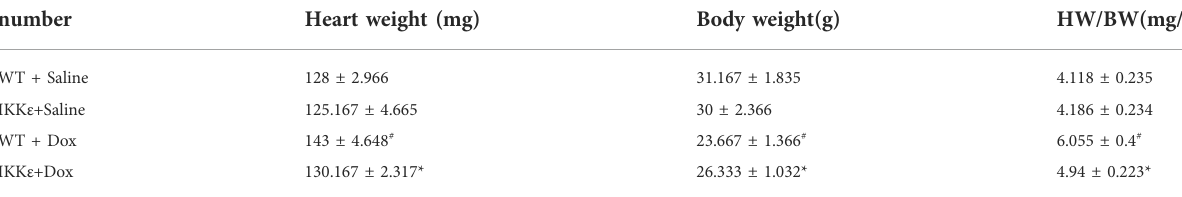
TABLE 1 heart weight and body weight of mice after